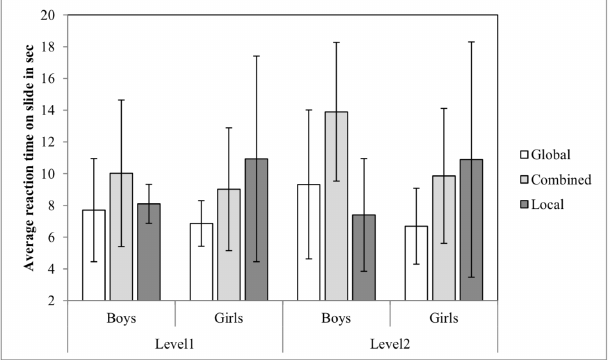
Figure 4. Average Reaction Time on Slide on the CWMR Test.